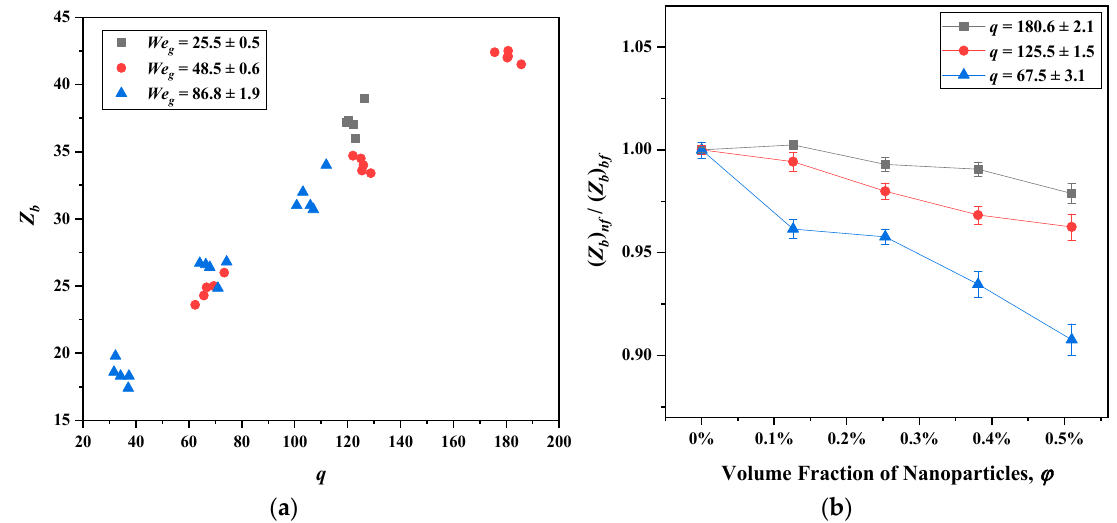
Figure 14. Z -positions of column fracture in different cases: ( a ) Different We g and q ; ( b ) Different q and φ .